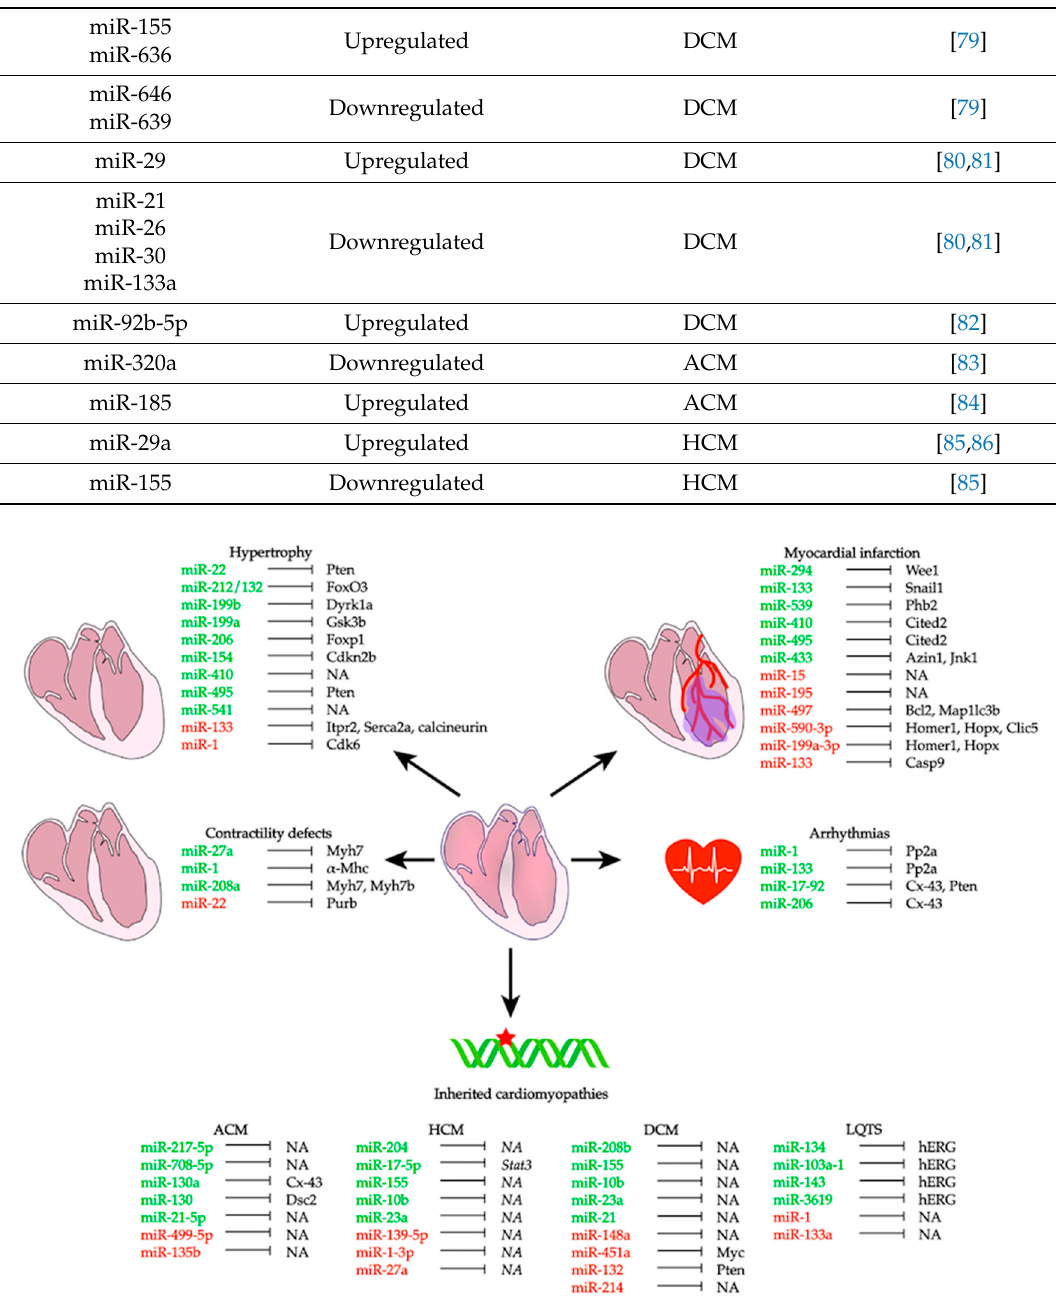
Figure 2. MiRNAs and the relative targets associated with cardiac diseases. Green miRNAs are upregulated, while red miRNAs are downregulated in the different diseases. NA , not available.